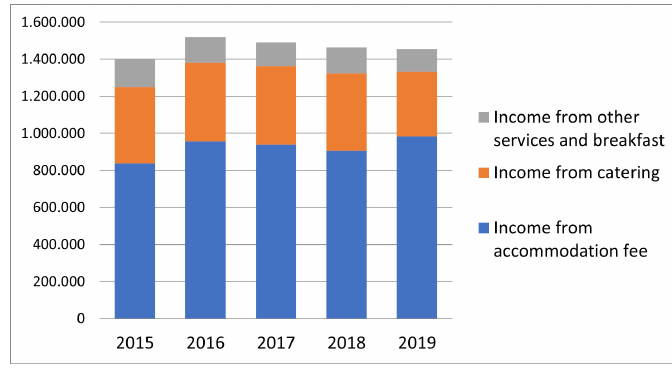
Figure 2: Income of accommodation establishments of Veszpr´em district (thousand HUF)